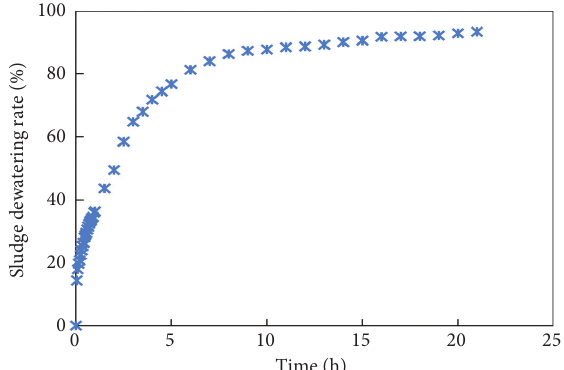
Figure 8: Sludge dewatering rate with rice straw.